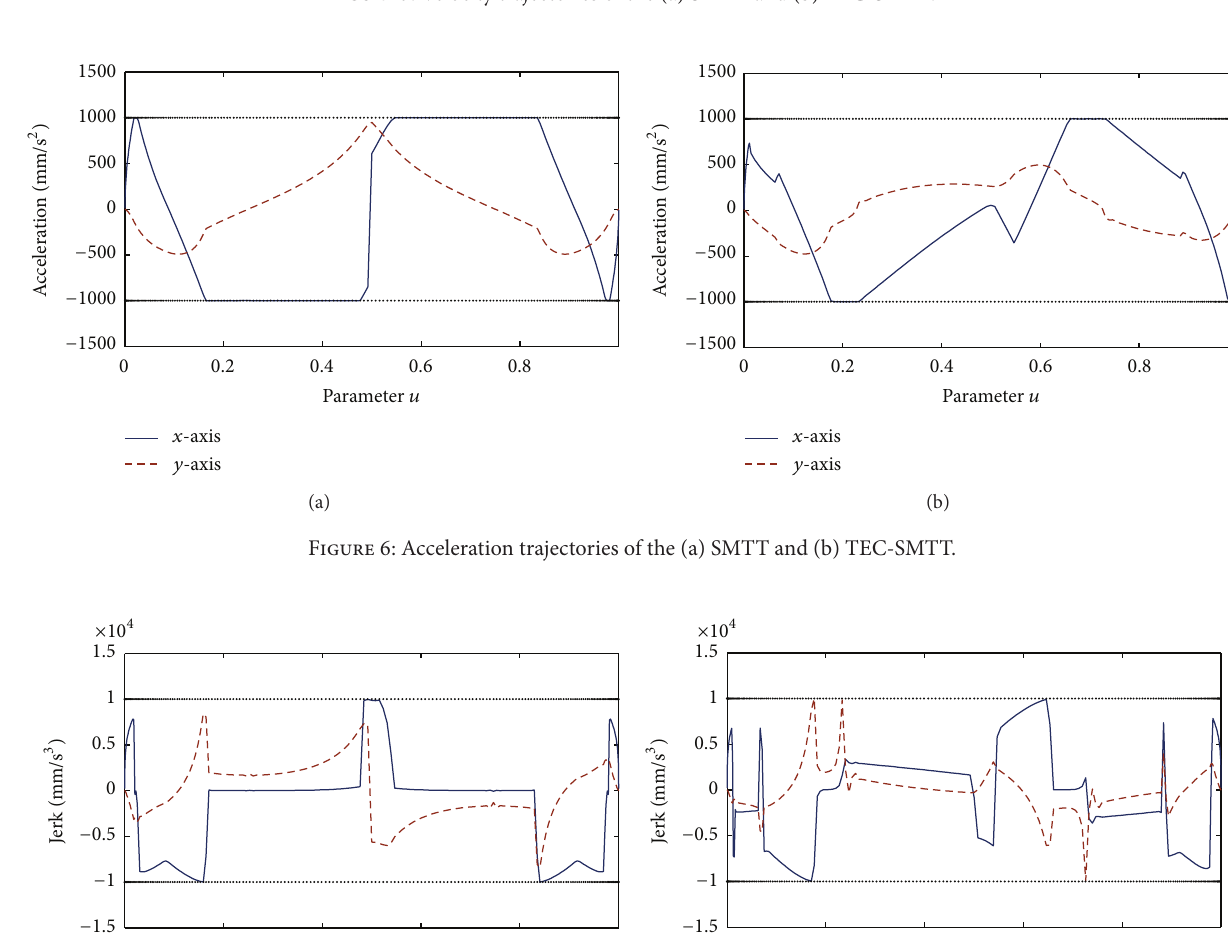
Figure 5: Velocity trajectories of the (a) SMTT and (b) TEC-SMTT.